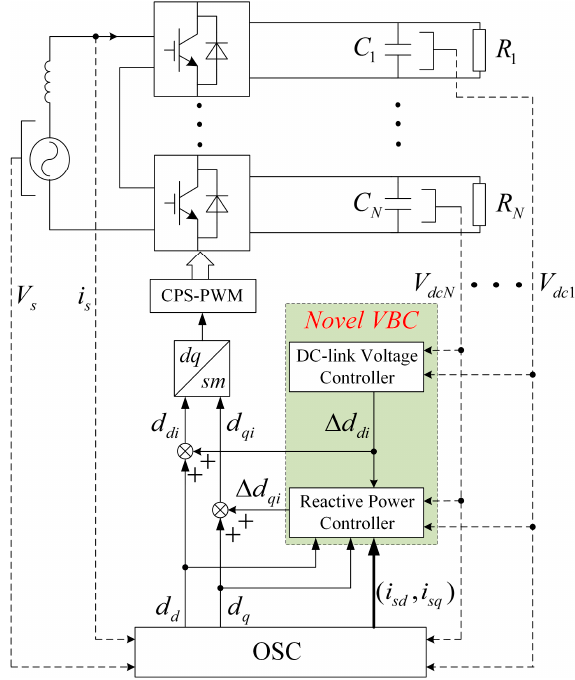
Figure 3. The block diagram of the proposed voltage-balancing controller (VBC).